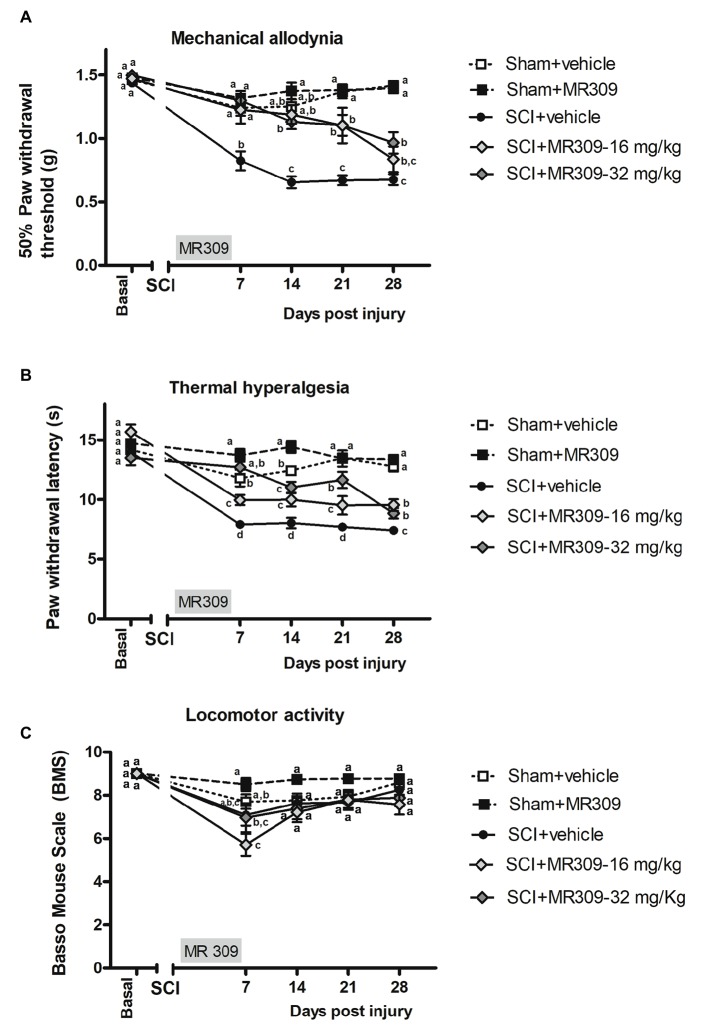
Time-course assessment of mechanical allodynia, thermal hyperalgesia, and locomotor activity after preventive sigma-1 receptor antagonist MR309 treatment. Each point and vertical line represent the mean ± SEM. Experimental groups: Sham-Veh (n = 17), Sham-MR309 (n = 13), SCI-Veh (n = 12), SCI-MR309-16 mg/kg (n = 7), and SCI-MR309-32 mg/kg (n = 13). a–c: groups not sharing a letter are significantly different, p < 0.05, by Duncan’s test (A) The MANOVA analysis of mechanical allodynia indicated significant effects on day (F(4,54) = 66.08, p < 0.001), treatment (F(4,57) = 46.59, p < 0.001), and interaction for day × treatment factors (F(16,165) = 8.53, p < 0.001). Significant group differences were found on post-injury days 7, 14, 21, and 28 (all p’s < 0.001) by ANOVA analysis. On the whole, mechanical allodynia is prevented in treated SCI-animals up to 14 dpi and attenuated until the end of experimental period. (B) The MANOVA analysis of thermal hyperalgesia indicated significant effects on day (F(4,58) = 55.59, p < 0.001), treatment (F(4,61) = 47.01, p < 0.001), and interaction for day × treatment factors (F(16,177) = 7.66, p < 0.001). Significant group differences were found on post-injury days 7, 14, 21, and 28 (all p’s < 0.001) by ANOVA analysis. Note that thermal hyperalgesia is prevented in MR309-32 mg/kg animals up to 7 dpi. Both doses significantly attenuate thermal hyperalgesia development up to 28 dpi. (C) The MANOVA analysis of BMS indicated significant effects on day (F(4,54) = 23.57, p < 0.001), treatment (F(4,57) = 5.01, p = 0.002) factors, and a lack of significant interaction for day × treatment (F(16,168) = 1.63, p = 0.089). Significant group differences were identified only at 7 dpi by ANOVA analysis. Considering BMS scale parameters, mild BMS alterations referring to altered paw position but not to altered horizontal locomotion, at 7 dpi. No significant differences between groups from 14 to 28 dpi.